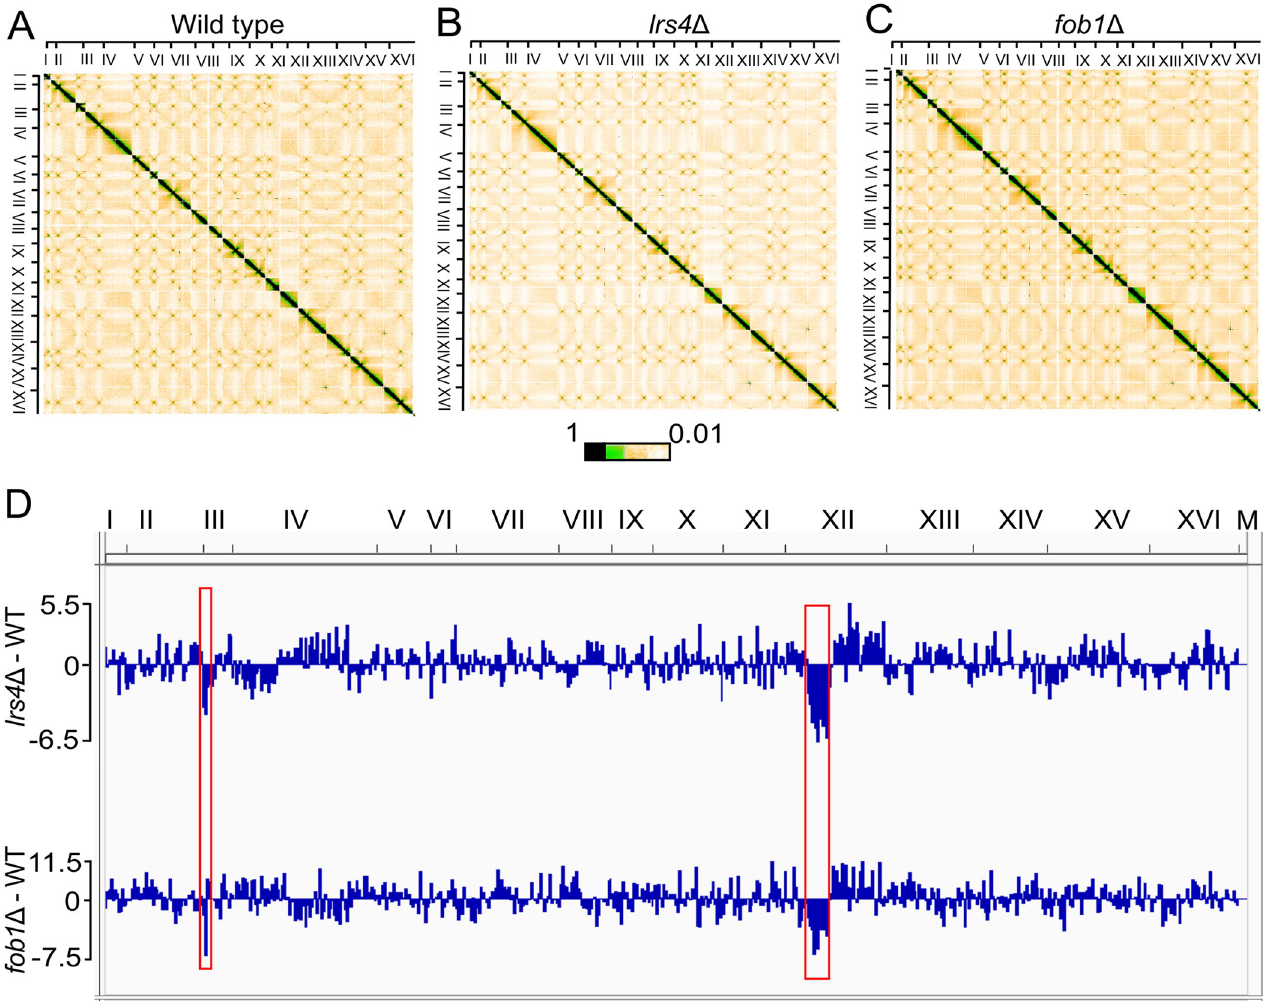
Fig 6. Micro-C XL analysis of the yeast genome in lrs4 Δ and fob1 Δ mutants. ( A-C ) Genome-wide interaction heatmaps of Micro-C XL data in exponentially growing MAT a wild type, lrs4 Δ and fob1 Δ cells, respectively. Each pixel represents normalized chromatin contacts between 10 kb bins. The color scale indicates maximum and minimum interaction counts from 10kb intervals across the genome. ( D ) Differential Chromatin Interaction (DCI) scores were calculated for normalized contact frequencies of 5kb target across +/-200kb flanking regions, comparing lrs4 Δ or fob1 Δ mutants with WT. Sequencing reads were pooled from 3 WT and 3 lrs4 Δ biological replicates, and 2 fob1 Δ replicates. The negative DCI scores observed in chromosome III and chromosome XII are boxed in